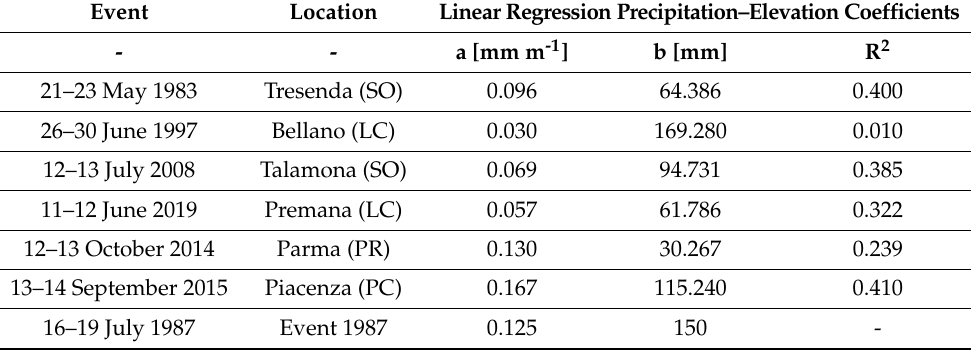
Table 5. Linear regression coefficient and R 2 calculated for the event simulated by LUME. Note the poor score of the regression, especially for the Bellano 1997 event, while for the others, the R 2 is always somewhat below